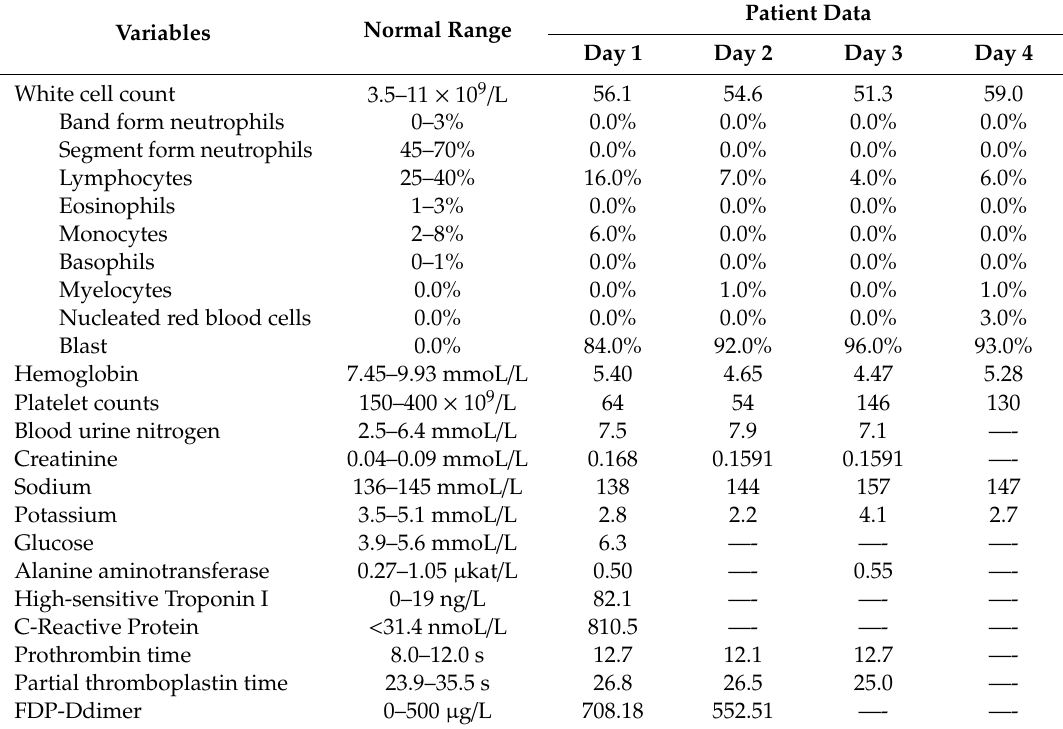
Table 1. The laboratory evaluation in this